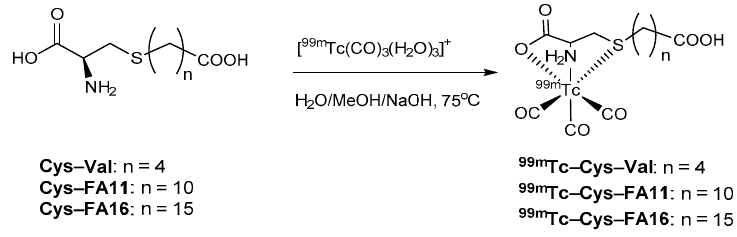
Scheme 3. Synthesis of ligands and rhenium complexes.